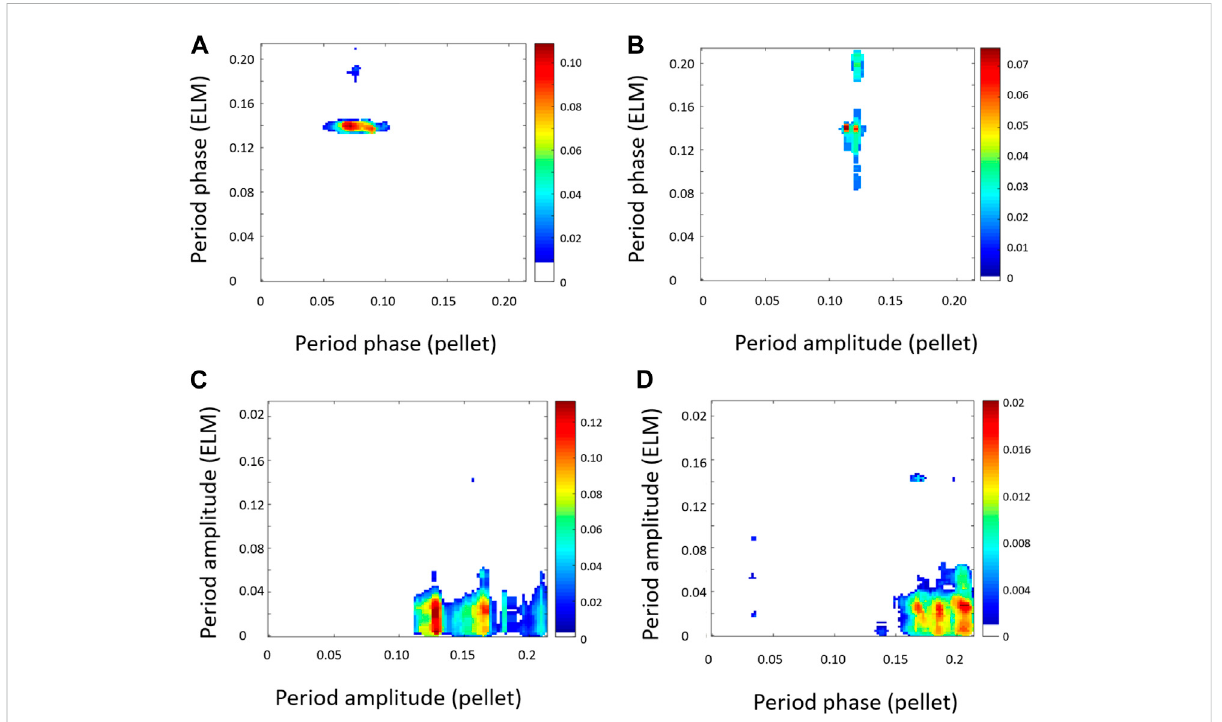
FIGURE 10 CMI plots patterns showing causal interactions between pellets and ELMs time series for AUG pulse #34462, for the time interval 5.2 – 5.5s: phase-phase (A) , amplitude-phase (B) , amplitude-amplitude (C) and phase-amplitude (D) . Amplitude-amplitude causal interactions are the dominanteffectbutthephase-phaseinteractionsareofthesameorderofmagnitude.Thecolourcoderepresentsthelevelofcouplingderivedwith theconditionalmutualinformationCMI.Periodsaremeasuredinseconds.The fi guresdisplaythepositivesigni fi cance-leveldeviationsfromthe 99th percentile of the average CMI calculated using 50 Fourier transform